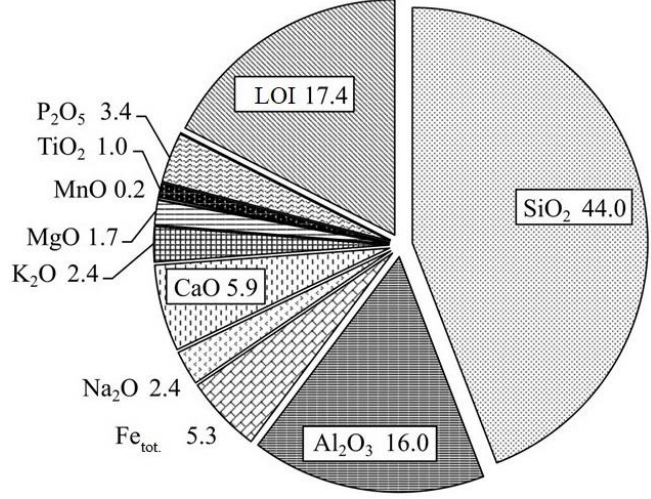
Figure 3. The average content (%) of the main elements and organic matter (LOI) in the modern sediments of Lake Bolshoy Vudjavr.